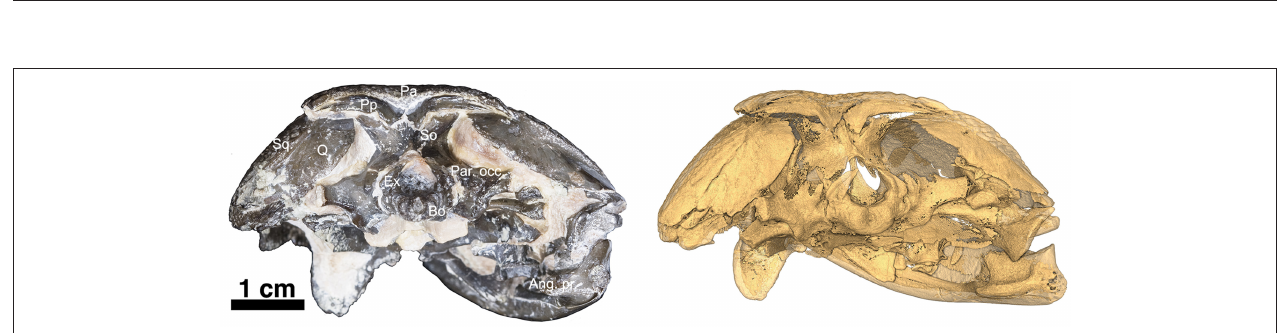
FIGURE 3 | OMNH73281a – Occipital view of Captorhinus kierani . Photograph (Left) of the occiput and isomorphic rendering of neutron scan (Right) showing the occipital elements. Note the incomplete ossification of the opisthotics which support the sub-adult status of the specimen. Also, note how the post-parietals are restricted to the occipital margin of the skull, lack the ornamental sculpting that is found in Captorhinus aguti , and are excavated along their horizontal axis producing an elongate sulcus—a trait diagnostic of the species.